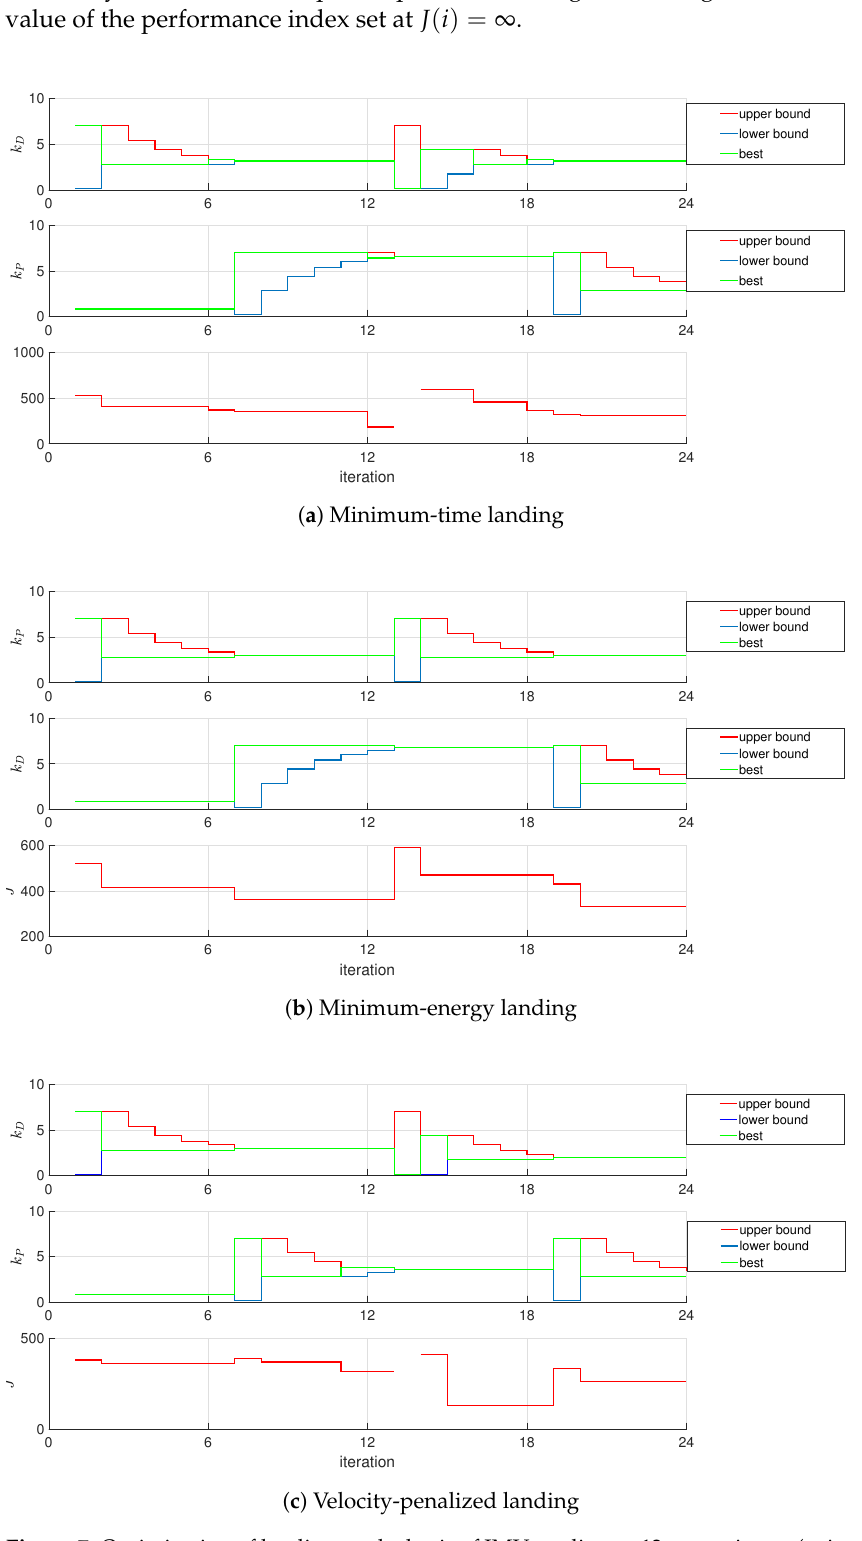
Figure 7. Optimization of landing on the basis of IMU readings—12s experiment (gain plots, missing J data denotes